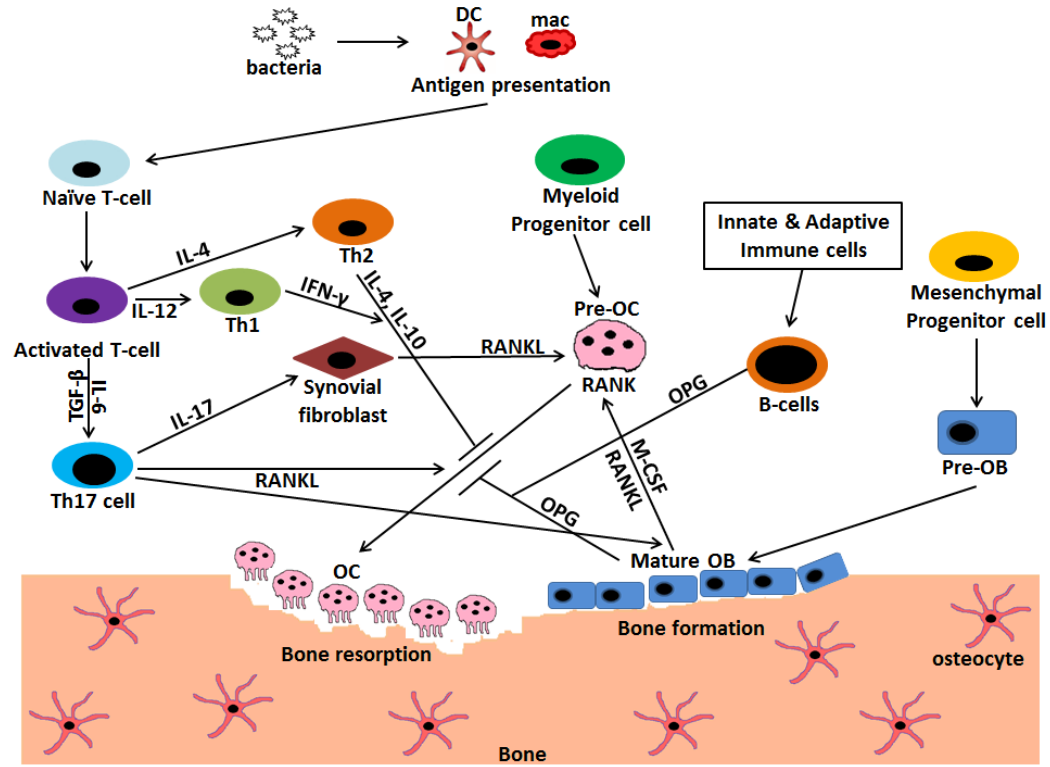
Figure 3. Interaction and crosstalk between immune cells, osteoblasts, and osteoclasts mediated via di ff erent cytokines regulate the extent of bone erosion during infection. Osteoclasts (OC) are the cells of myeloid origin that degrade the bone matrix, whereas osteoblasts (OB) are the bone forming cells that have mesenchymal origin. Bacterial entry into the host initiates a complex crosstalk between immune cells, mainly, T and B cells with osteoclasts. The invading pathogen is phagocytized and presented by macrophages (mac) and dendritic cells (DC) to activate T cells. These activated T cells further get di ff erentiated into T helper (Th) 1, Th2, and Th17 subsets. Th17 is the prominent osteoclastogenic T cell subset which expresses receptor activator of NF- κ B ligand (RANKL) and induces the formation of osteoclasts by binding to RANK on pre-osteoclasts. It also secretes IL-17 that induces the synovial fibroblasts as well as osteoblasts to express RANKL further leading to osteoclastogenesis. Contrarily, Th1 and Th2 subset of T cells inhibits osteoclastogenesis by secreting cytokines INF- γ , IL-4 and IL-10 respectively. B cells, being activated by innate and adaptive immune cells, secrete OPG, which acts as an inhibitor to osteoclast formation process. Osteoblasts also secrete macrophage-colony-stimulating factor (M-CSF) and RANKL that aids in the process of osteoclastogenesis.